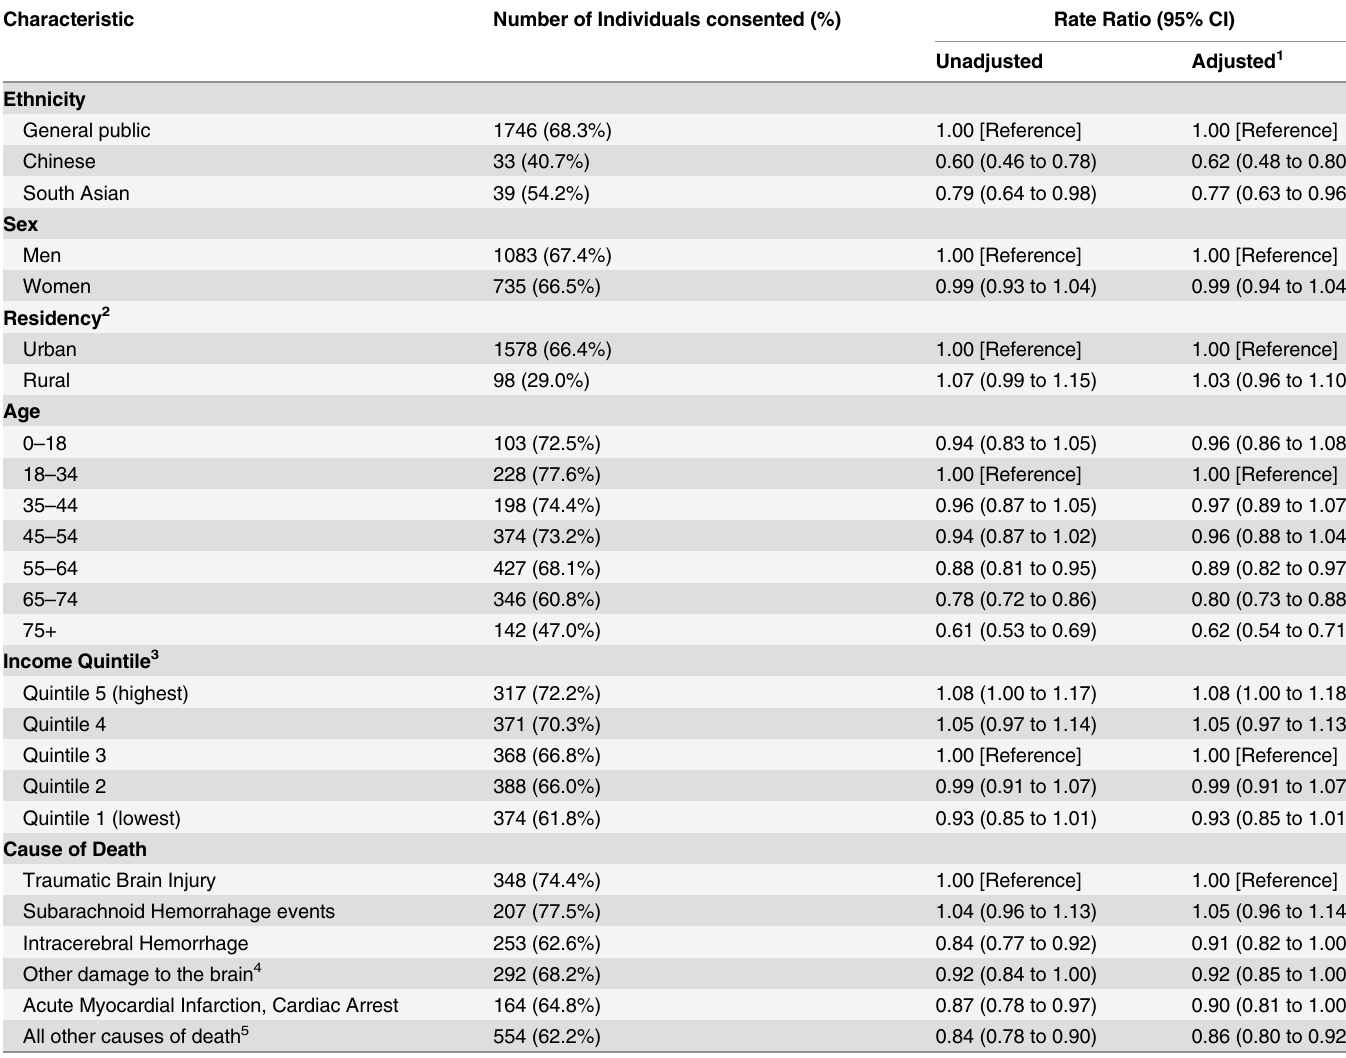
Table 4. Factors associated with Familial Consent (Cohort